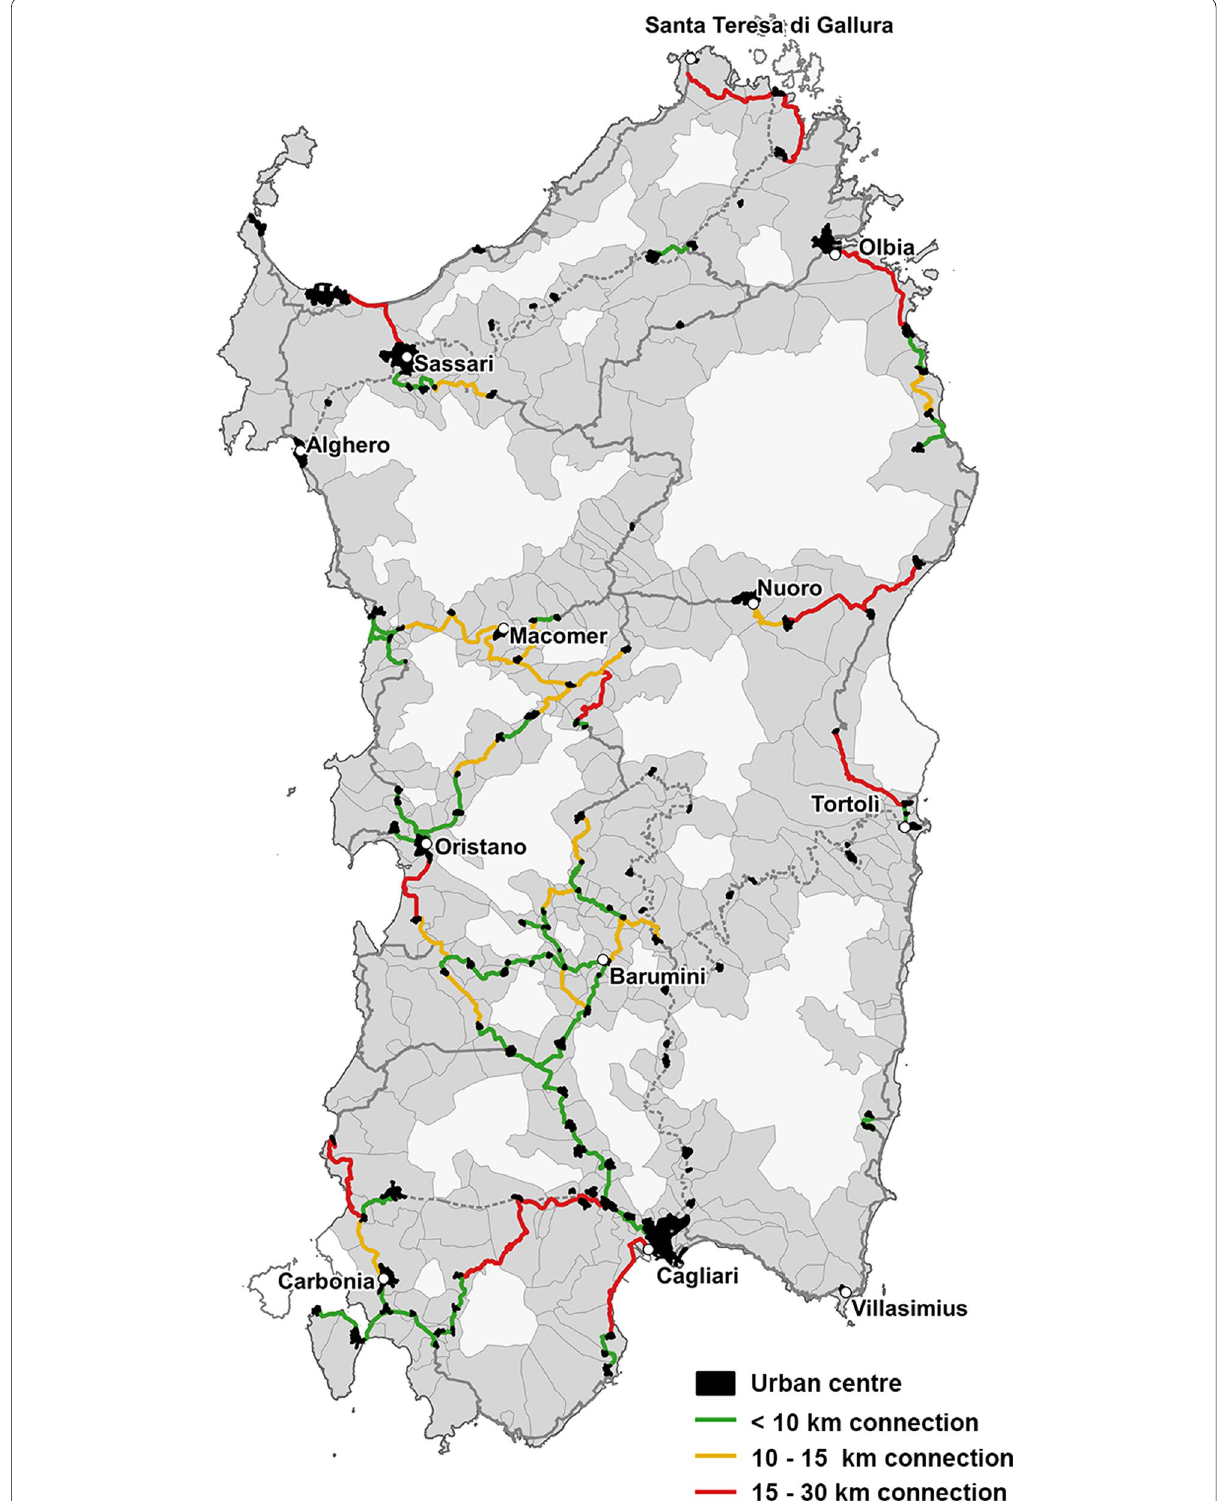
Fig. 10 Connections between urban centres provided by the cycle network in the ranges 0–10 km, 10–15 km, and 15–30